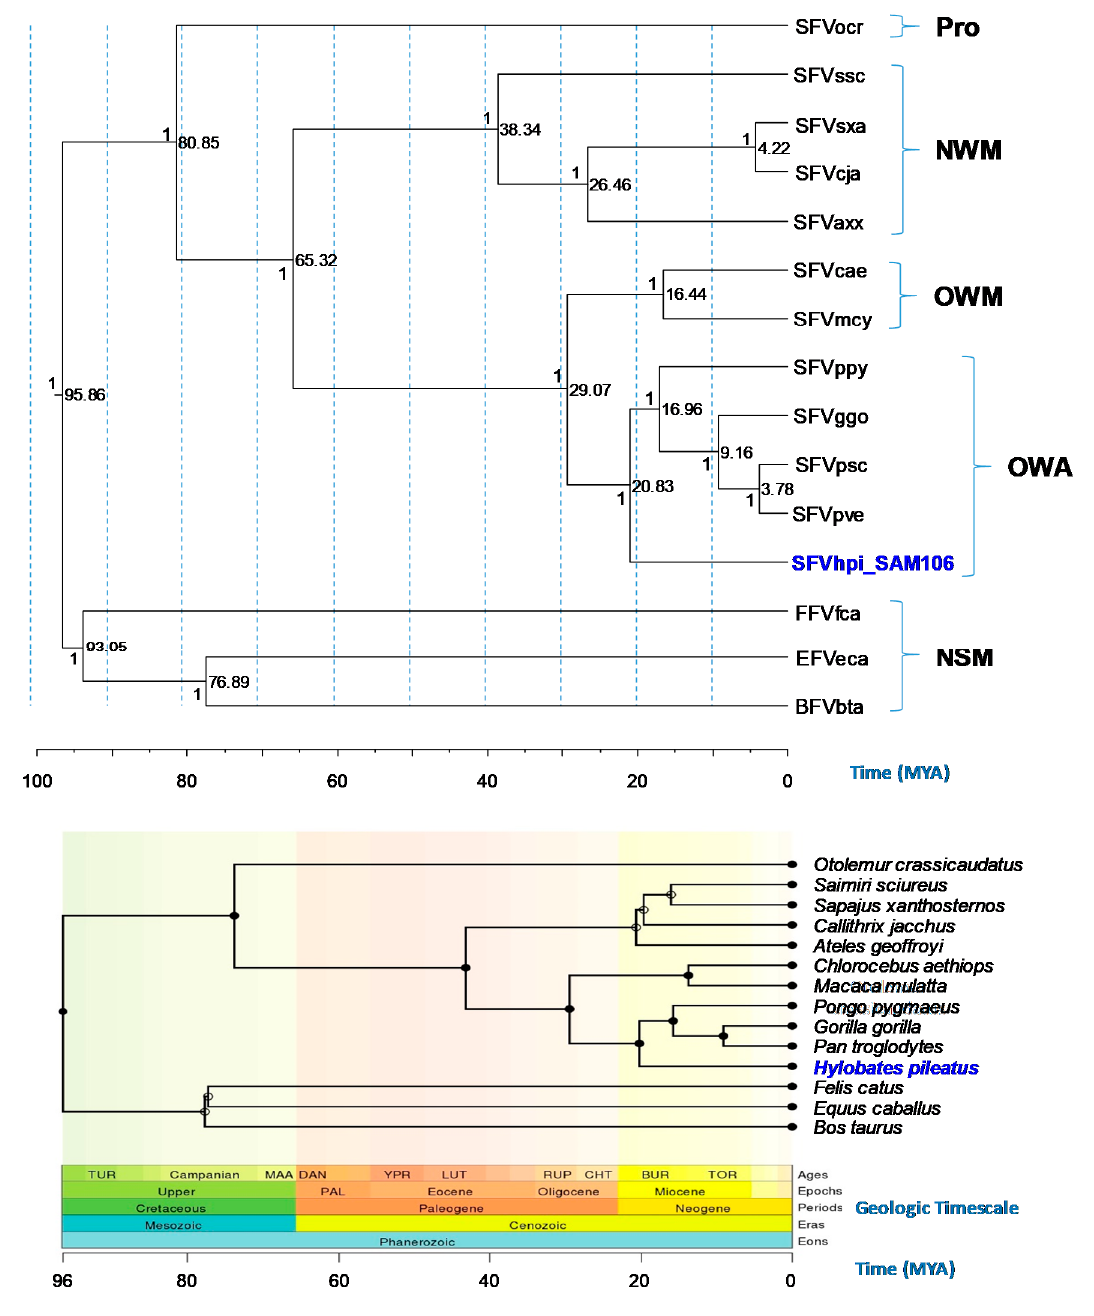
Figure 3. Evolutionary relationships and divergence dates of foamy viruses (FVs) and their mammalian hosts. ( A ) FV phylogeny inferred using gag-pol-env concatamer (~7.4 kb). ( B ) FV phylogeny inferred using the first and second coding positions of the gag-pol-env concatamer (~4.9-kb). Phylogeny inferred using BEAST and mammalian host phylogeny inferred at Timetree.org as well as the corresponding geologic timescale. Old World apes (OWAs): SFVpve, Pan troglodytes verus (chimpanzee), GenBank accession number U04327; SFVpsc, Pan troglodytes schweinfurthii (chimpanzee), Y07725; SFVppy, Pongo pygmaeus (orangutan), AJ544579; SFVggo, Gorilla gorilla (gorilla), NC_039029; SFVhpi_SAM106, Hylobates pileatus , (pileated gibbon) M621235. Old World monkeys (OWMs): SFVcae, Cercopithecus aethiops (African green monkey), M74895; SFVmcy, Macaca cyclopsis (macaque), X54482. New World monkeys (NWM): SFVcja, Callithrix jacchus (common marmoset), GU356395; SFVsxa, Sapajus xanthosternos (capuchin), KP143760; SFVaxx, Ateles species (spider monkey), EU010385; SFVssc, Saimiri sciureus (squirrel monkey), GU356394. Prosimian (Pro):